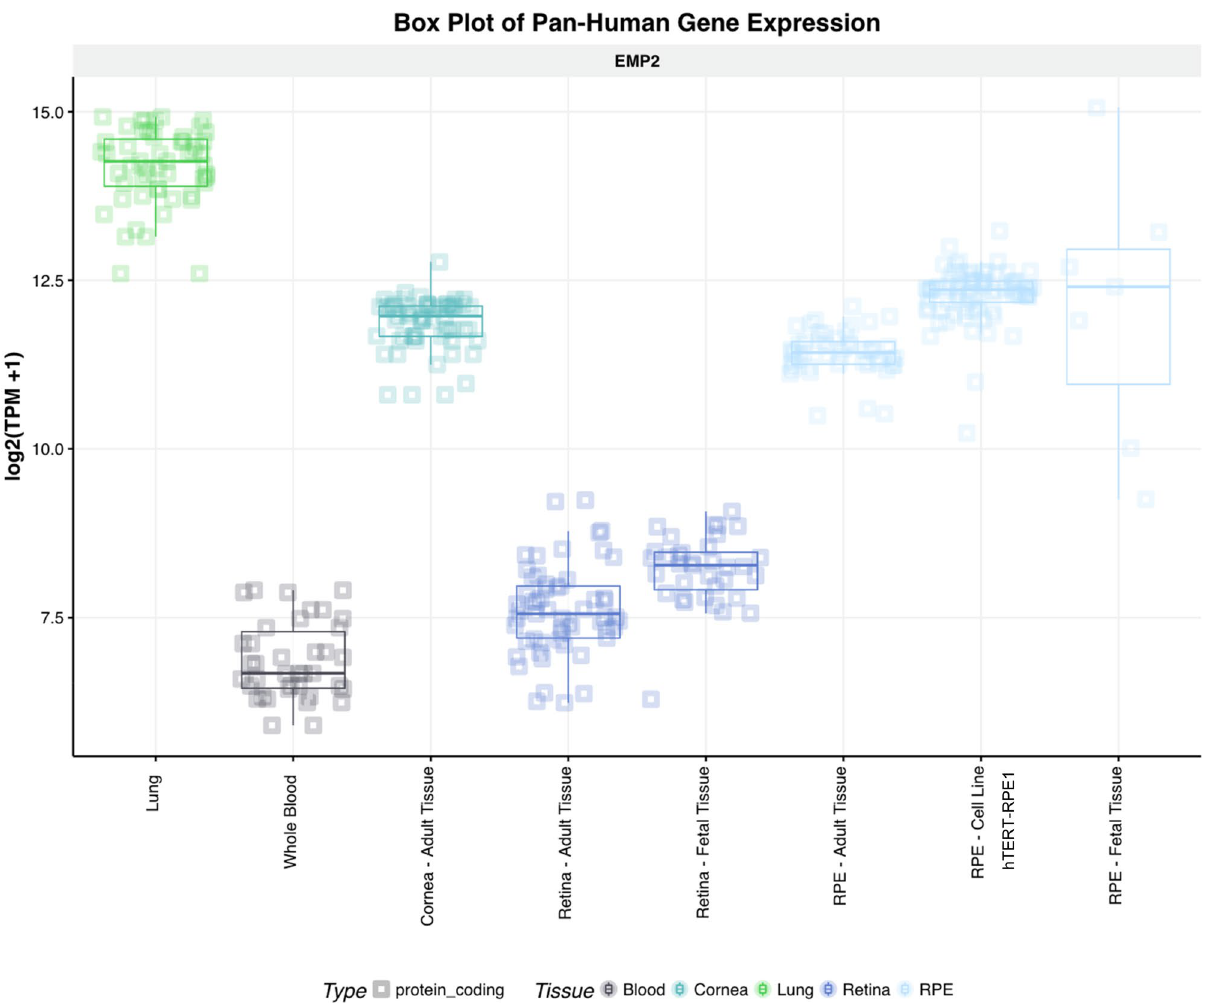
Figure 1. Differential expression of EMP2 in ocular tissues. Visualization generated using the NEI EyeIntegration web resource (https:// eyeIn tegra tion. nei. nih. gov), queried for differential expression of EMP2 in specific eye tissues of interest including adult cornea, adult retina, fetal retina, adult RPE, fetal RPE, and RPE cell line. Expression within these ocular sites was compared to EMP2 in the lung and whole blood, sites confirmed to have high and low expression of the transcript, respectively 17 . RPE cell line used is the hTERT-RPE1 line. Data obtained from EyeIntegration version 1.05 using the Gene 2019